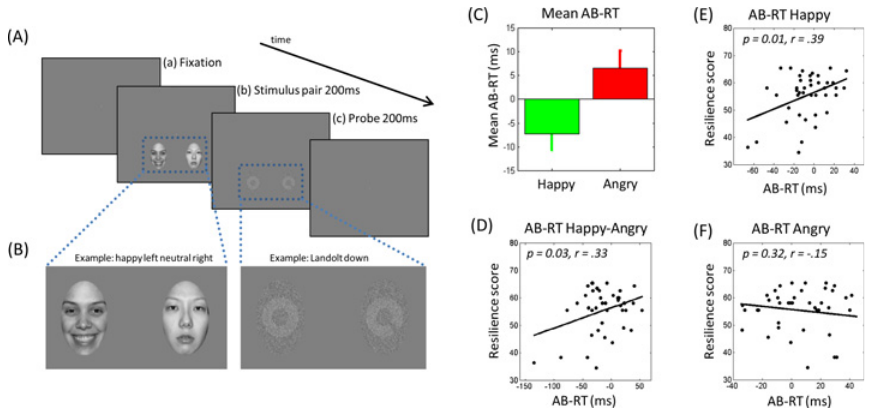
Fig 1. Task and behavioral results. (A, B) Modified Dot-Probe Task, (C) Mean AB reaction time scores, (D) Pearson correlations between AB happy — AB angry difference and resilience, and (E-F) between AB scores and